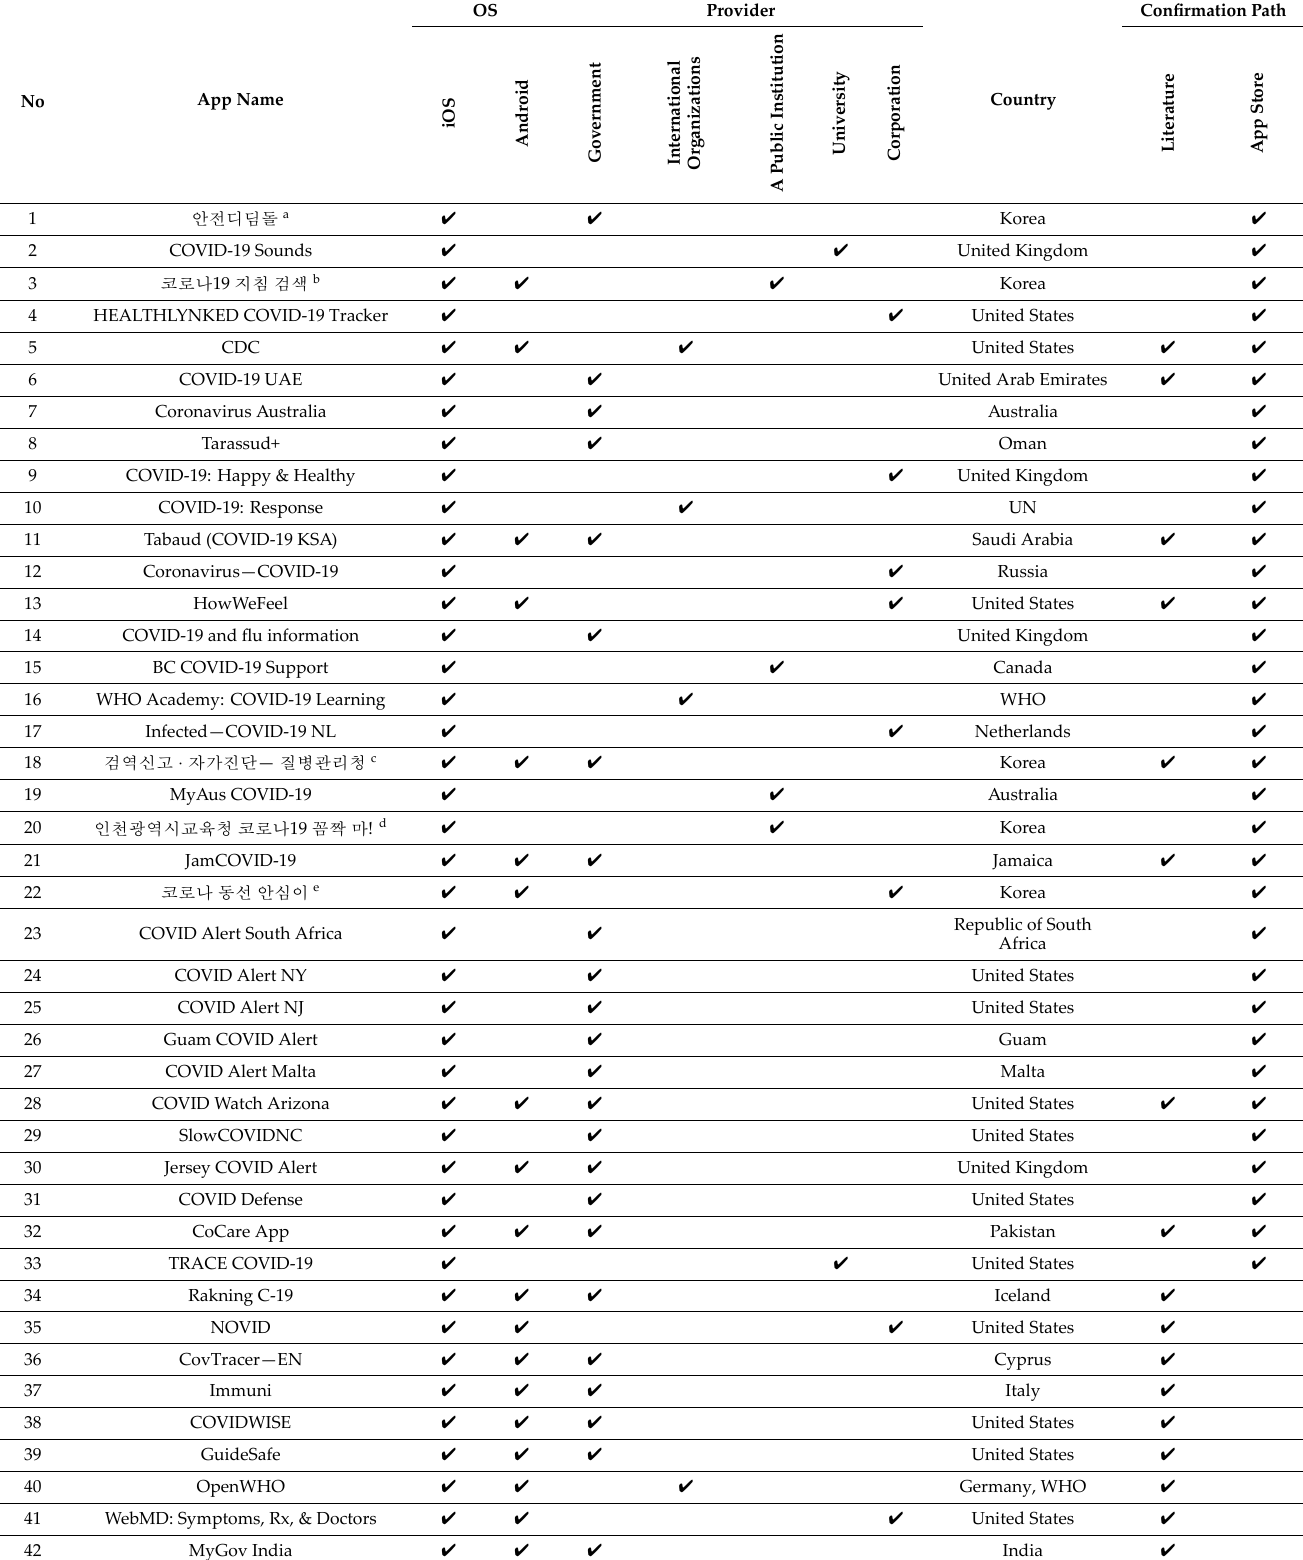
Table 2. List of apps for final